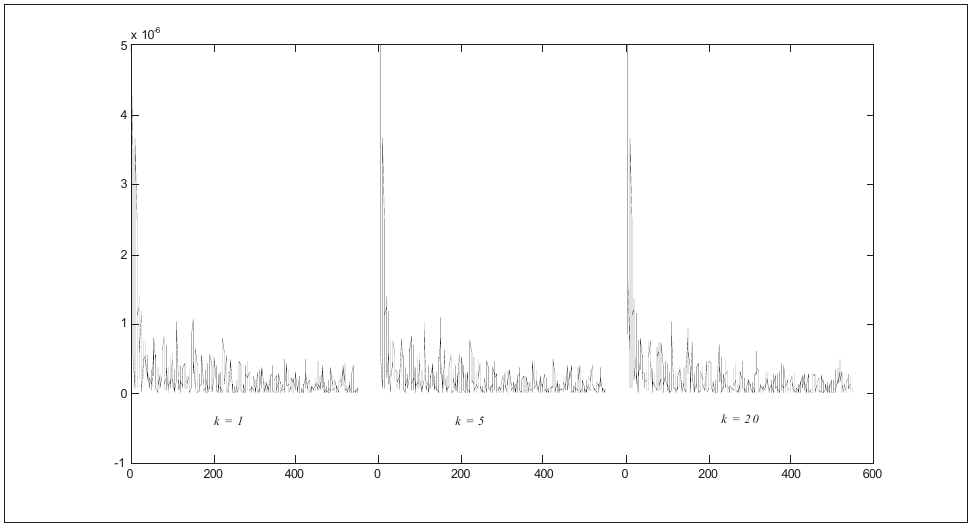
Figure 1. The periodogram of the squared daily returns (left), the 5-periods aggregation of the squared daily returns divided by 5 (middle), and the 20-periods aggregation of the squared daily returns divided by 20 (right) for the daily S&P 500 returns data. The sample period is from August 13, 1928 to December 30, 2011.